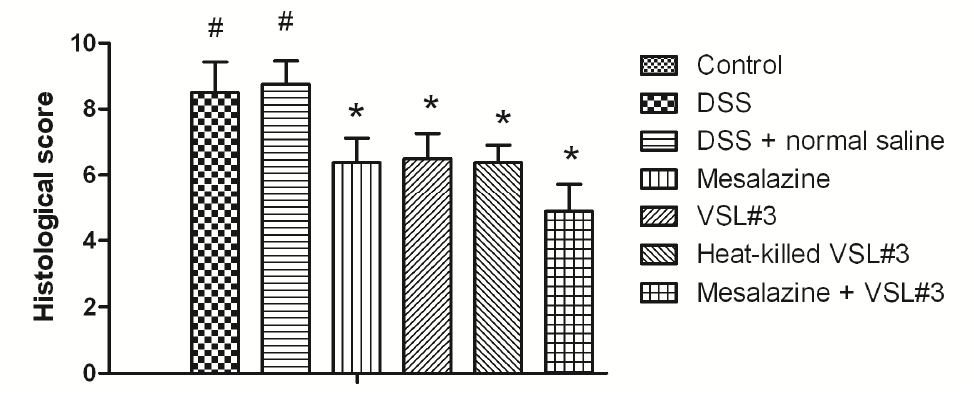
Figure 2. Histology injury score ( # p < 0.05 versus control group; * p < 0.05 versus DSS